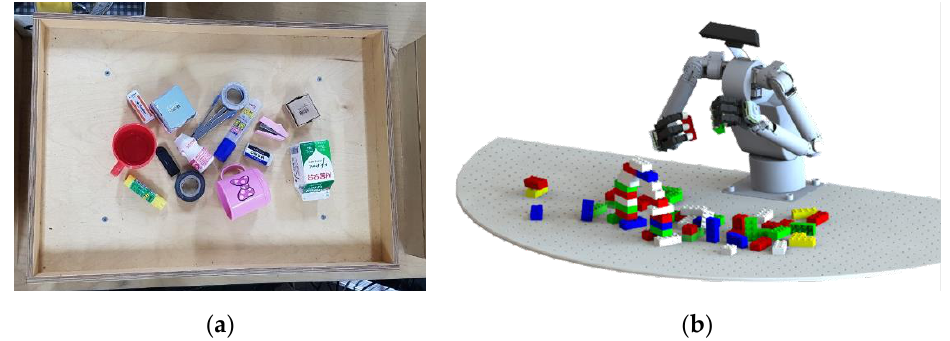
Figure 1. Potential applications of singulation: ( a ) Living room; ( b ) LEGO parts-based assembly by a robot manipulator.